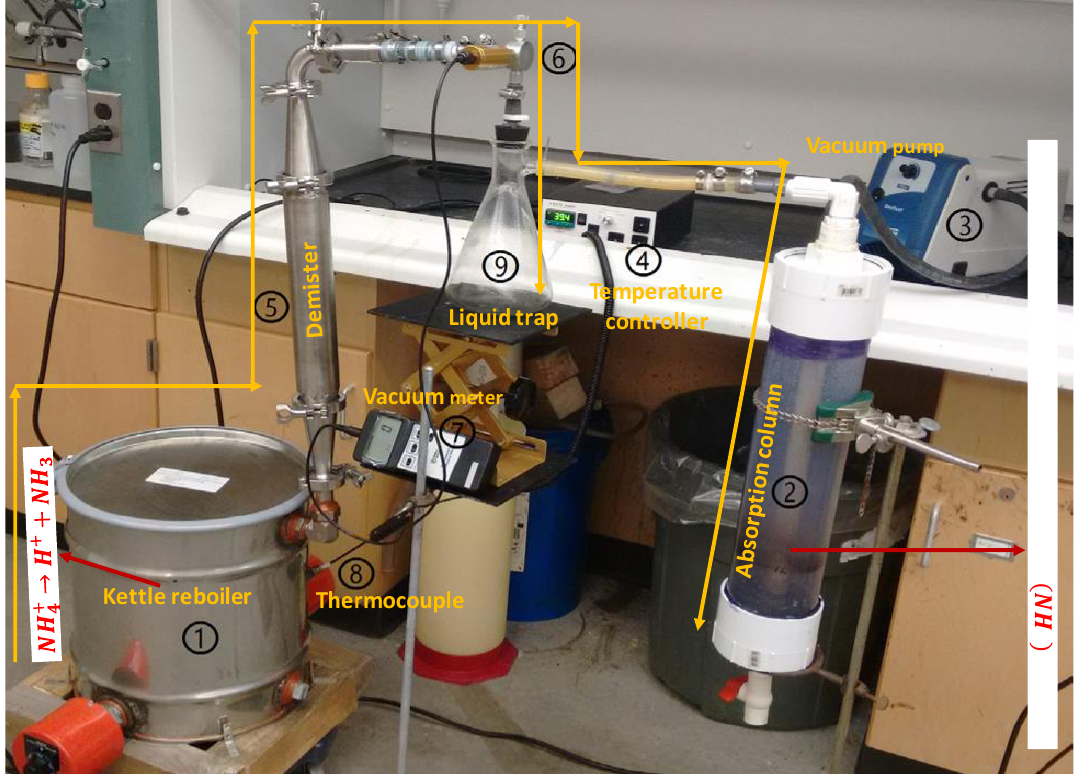
Figure 8. Innovative vacuum thermal stripping – acid absorption process for ammonia recovery — reproduced with permission from the original authors [239].